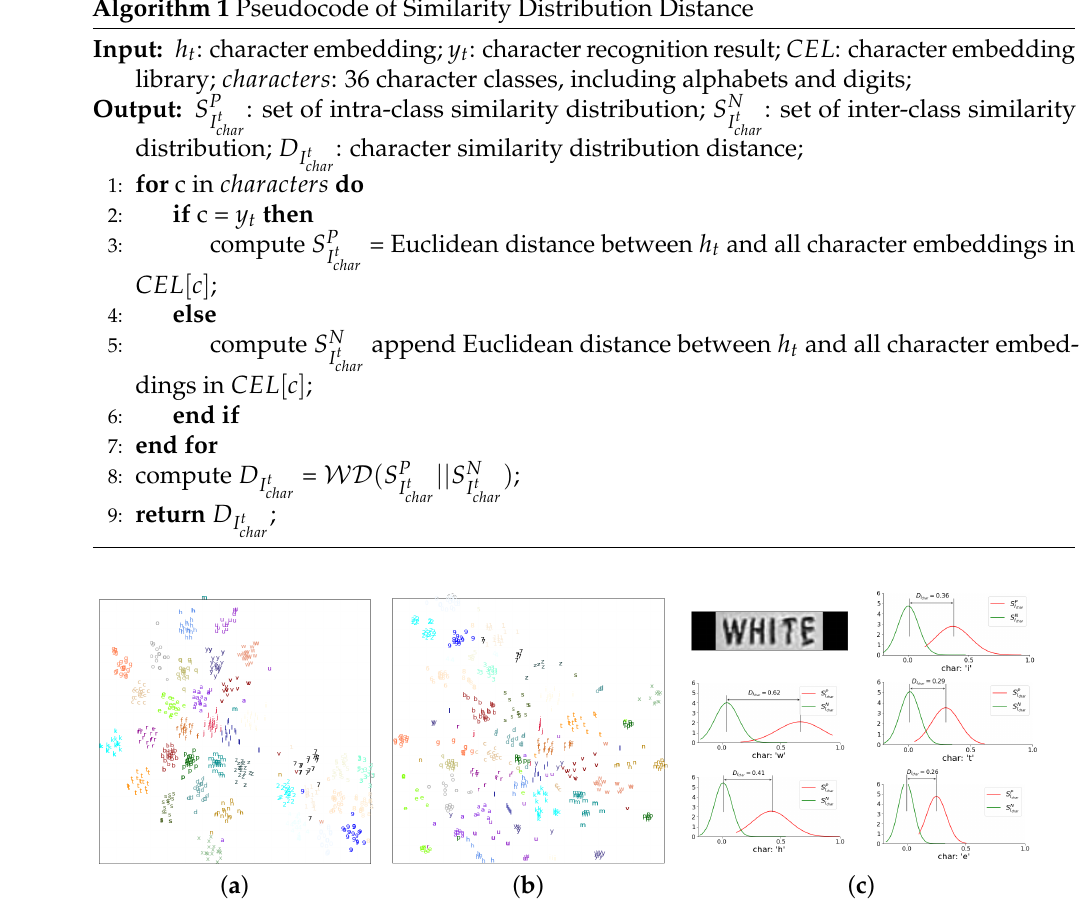
Figure 4. Embedding plot of 36 character classes from STR benchmark. ( a ): character embedding in the benchmark training set. ( b ): character embedding in the Hard high-resolution (HR) subset of Textzoom. The embeddings are dimension reduced using t-SNE. ( c ): illustration of the character similarity distribution